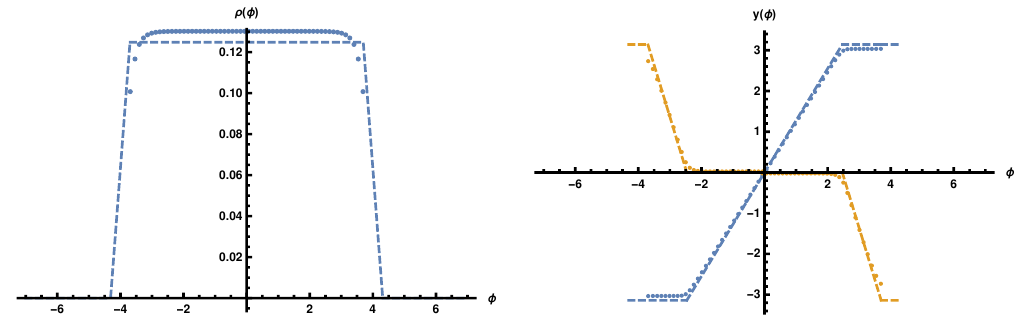
Figure 3 . Numerical (dots) and analytical (dashed lines) solutions for Laufer’s theory for (cid:1) = 1 k = 1, and N = 60. On the left we show the eigenvalue density (cid:26) ( x ), while on the right we